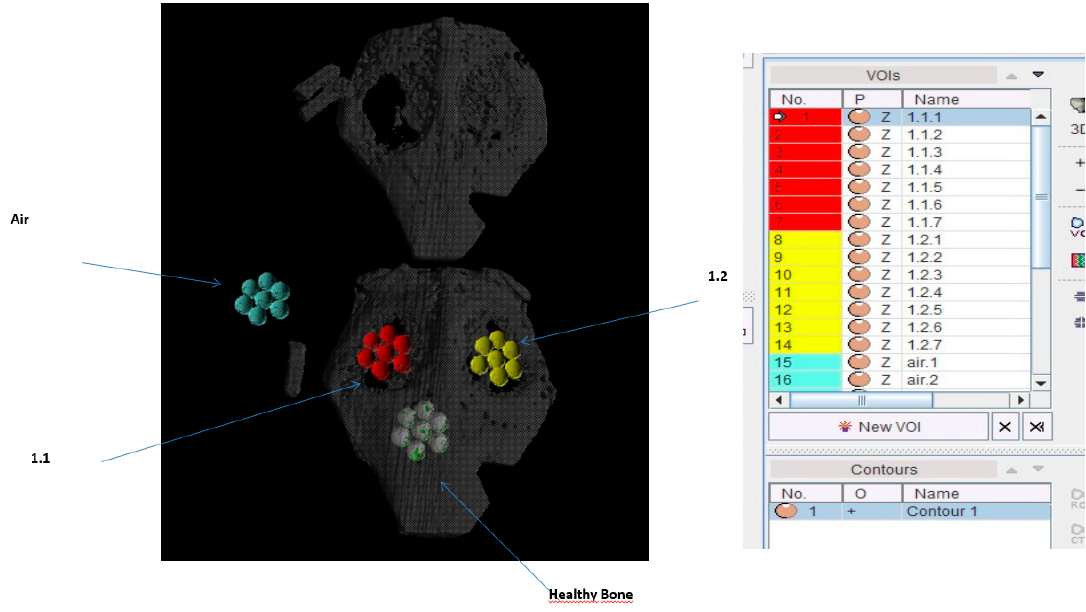
Figure 3. Microtomography study on animal skull.